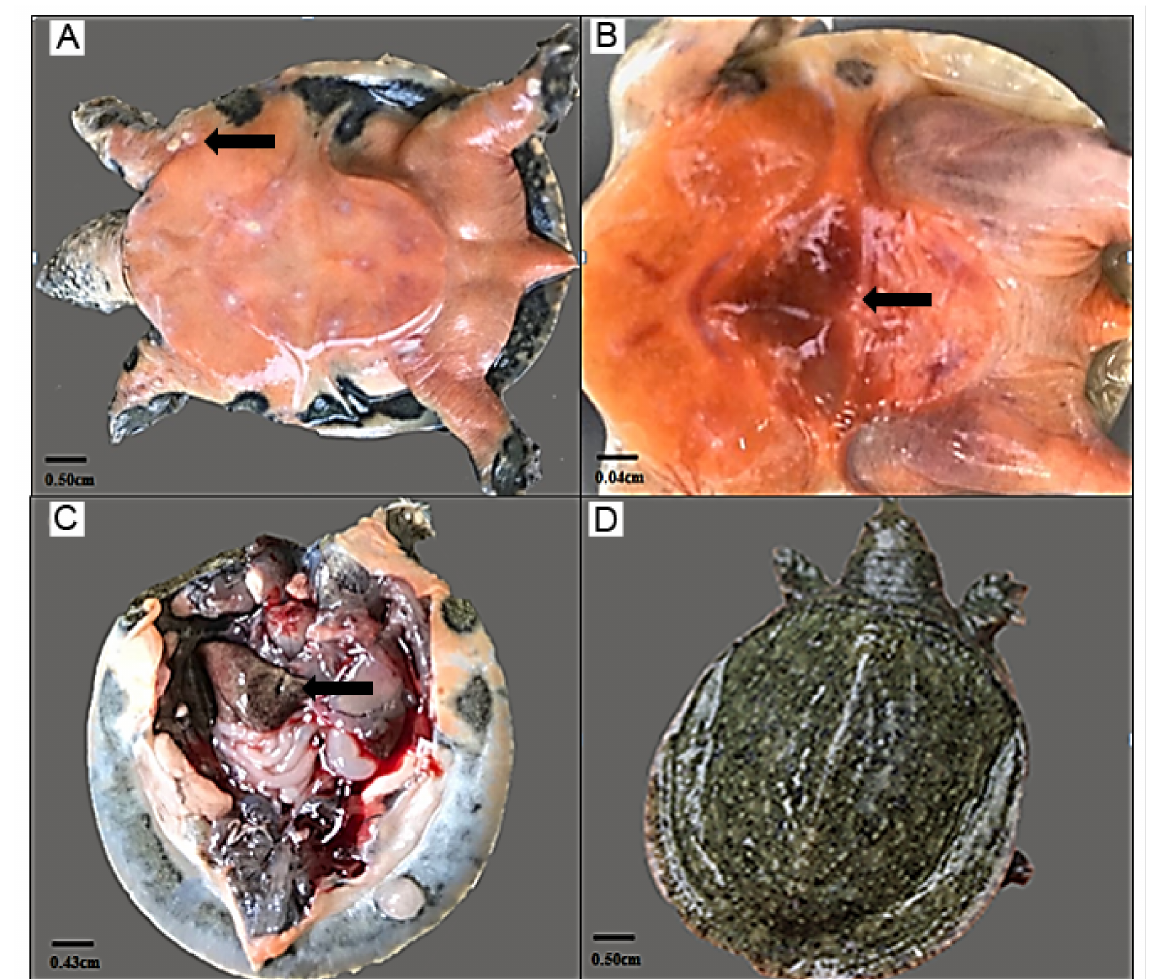
Figure 1. Pathological symptoms of turtles infected by A. hydrophila . The pathological symptoms on the body surface including ( A ) white spots near the axillae; ( B ) abdominal congestion in inactive subgroup turtles. ( C ) The pathological symptoms of viscera including liver, spleen, and intestines after anatomy of inactive turtles. ( D ) The active subgroup turtles showed no obvious pathological symptoms and were aggressive and active in feeding and moving. Black arrows indicate the location of pathological